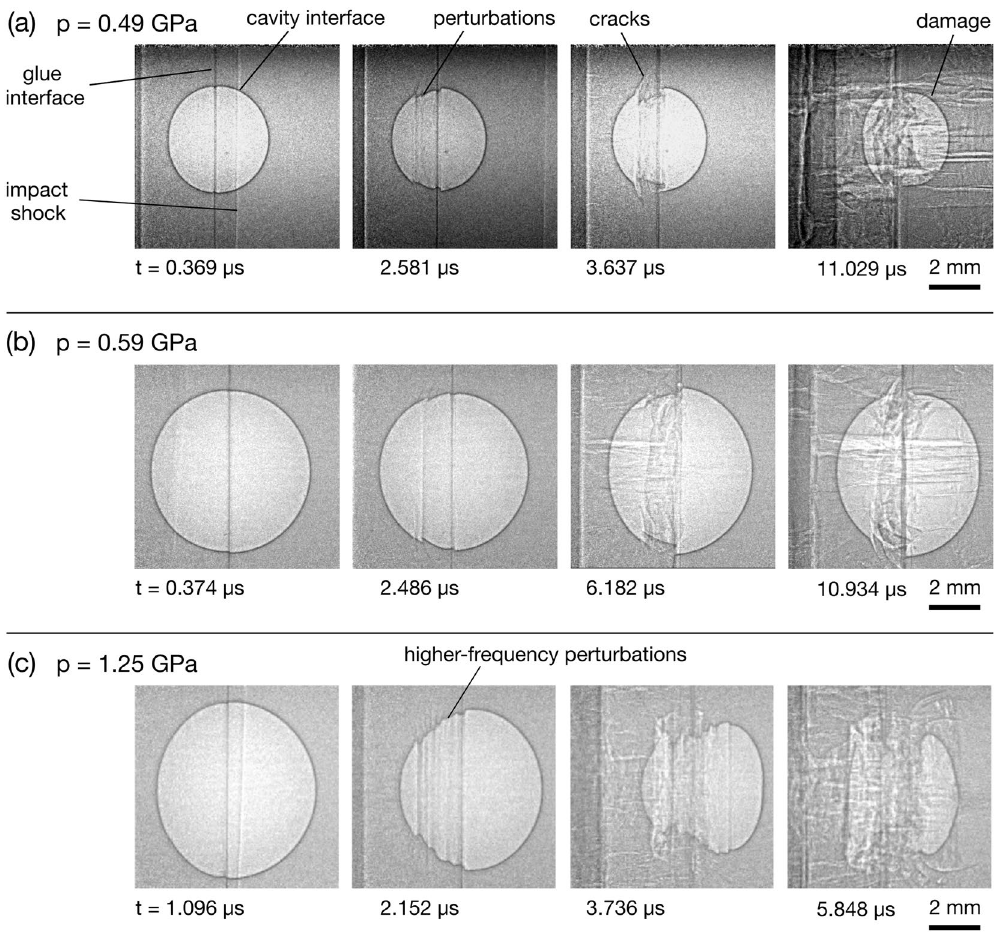
Figure 3. Radiograph sequences showing shock-cavity interactions in the strength-dominated regime. ( a ) A 4 mm cavity and 0.49 GPa shock. ( b ) A 6 mm cavity and 0.59 GPa shock. ( c ) A 6 mm cavity and 1.25 GPa